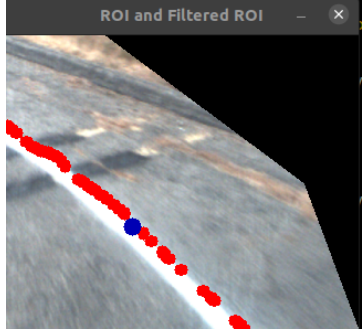
Figure 9. Image after applying Region of Interest